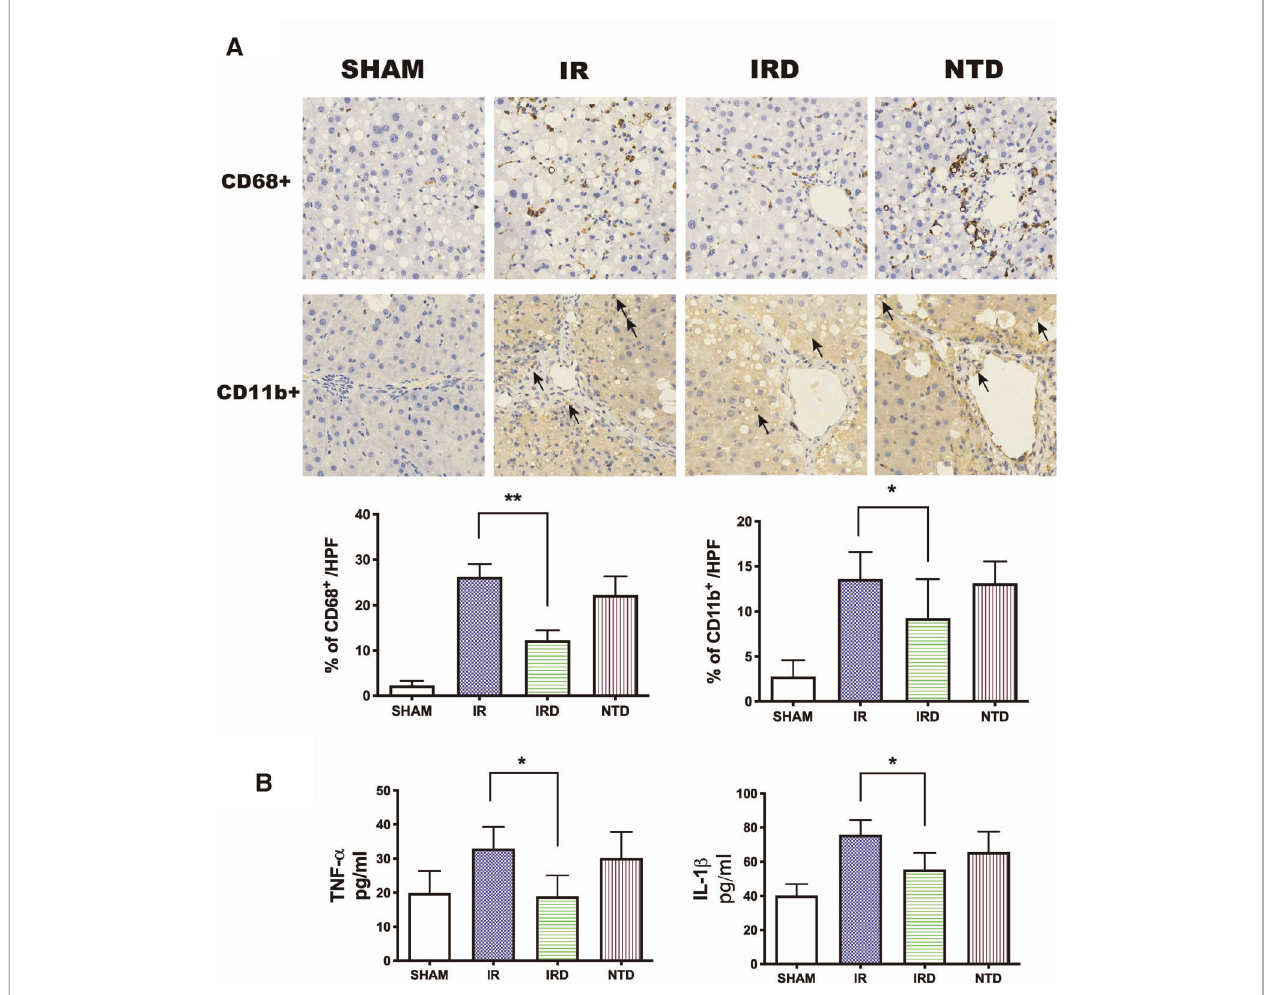
FIGURE 4 | DADLE treatment reduced in fl ammatory cell in fi ltration and serum cytokines levels. ( A ) Immunohistochemistry staining for and after 6 h of reperfusion. Original magni fi cation 400×, n =6, * p <0.05 compared with the IR group, ** p <0.01 compared with the IR group. The CD68 + positive cells were presented as brown. The black arrow indicates the CD11b + positive cell. ( B ) Serum concentrations of TNF- α and IL-1 β were lower in the IRD groups compared with the IR group; n =6, * p <0.05 compared with the IR group. IR, IRD, and NTD are the same rat groups as in Figure 2